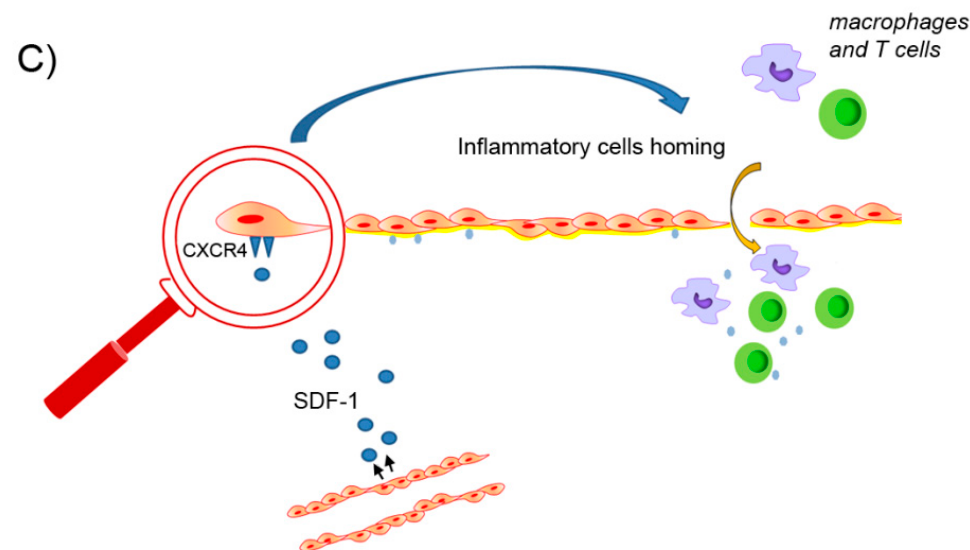
Figure 1. Schematic representation of Calcific Aortic Valve Disease (CAVD) pathogenesis. Collagen is the predominant component of the fibrosa in healthy cardiac valves, while the spongiosa and ventricularis are mainly composed of proteoglycans (PGs) and a collagen/elastin network, respectively. ( A ) Initial lesions, such as endothelial damage, account for the recruitment of inflammatory elements in the valve, triggering initial microcalcification. Resident cells such as VICs and VECs as well as circulating macrophages support the calcification process via the release of extracellular vesicles. Apoptotic myofibroblasts and immunity cells favor nucleation of calcium and phosphate. The resulting inflammatory microenvironment and myofibroblasts differentiation cause extracellular matrix (ECM) remodeling, valve thickening and fibrosis. Further differentiation in osteoblasts accounts for calcification, remodeling and biomineralization or ossification. Ectopic expression of TNC is also depicted. ( B ) Hypoxic conditions induce the formation of new ectopic vessels which in turn support ECM remodeling via MMP- and cathepsins-dependent degradation of collagen and elastic fibers, respectively. ( C ) The activation of the SDF-1/CXCR4 pathway in endothelial cells further stimulates the homing of inflammatory elements ( C ). CXCR4, C-X-C Motif Chemokine Receptor 4; EVs, extracellular vesicles; GAG, glycosaminoglycans; SDF-1, stromal cell-derived factor 1; TNC, tenascin-C; MMPs, matrix metalloproteinases; VECs, valve endothelial cells; VEGF, vascular endothelial growth factor; VICs, vascular interstitial